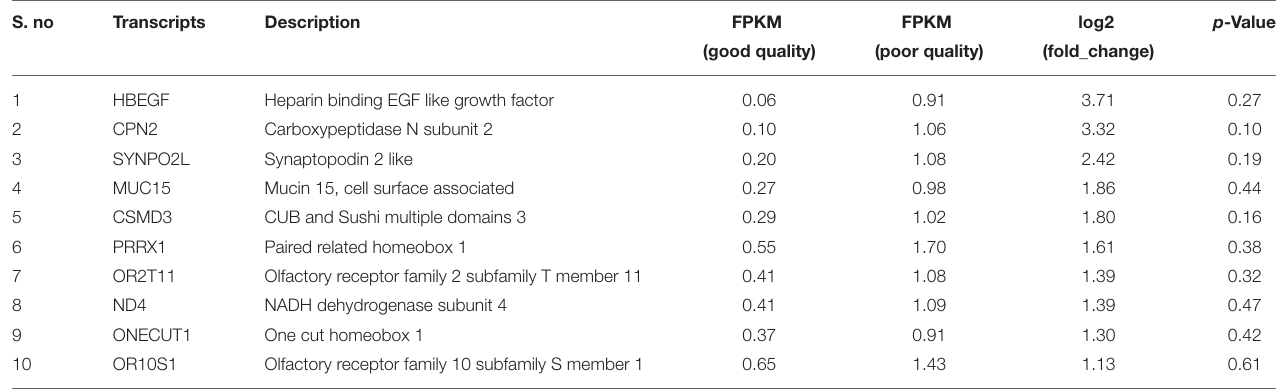
TABLE 2 | The top 10 upregulated transcripts in poor-quality semen compared with good quality semen. S. no